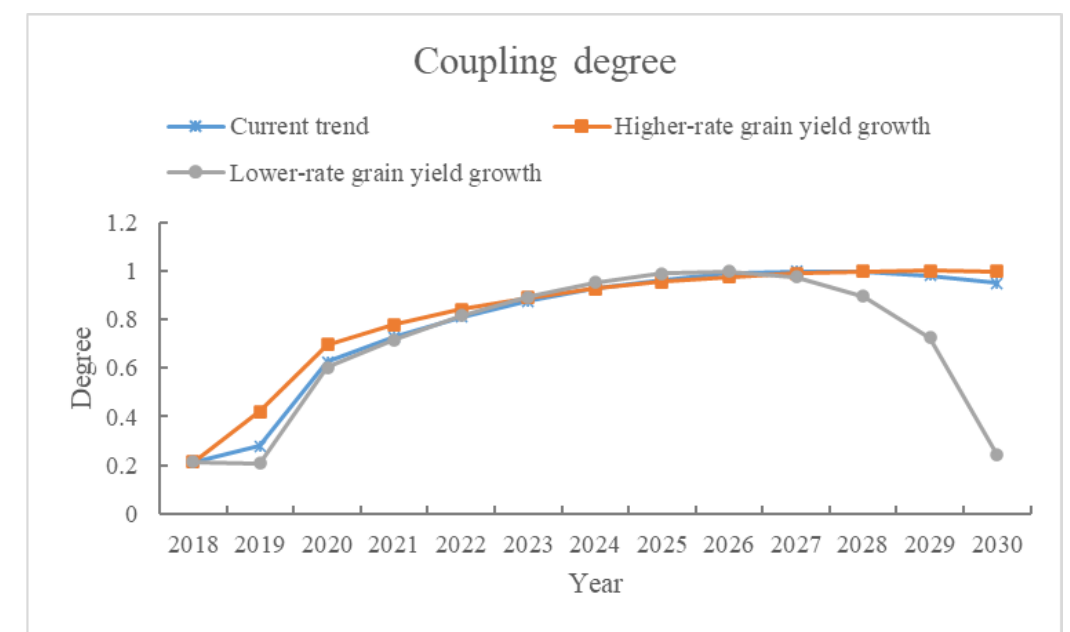
Figure 8. Coupling degree under three scenarios.